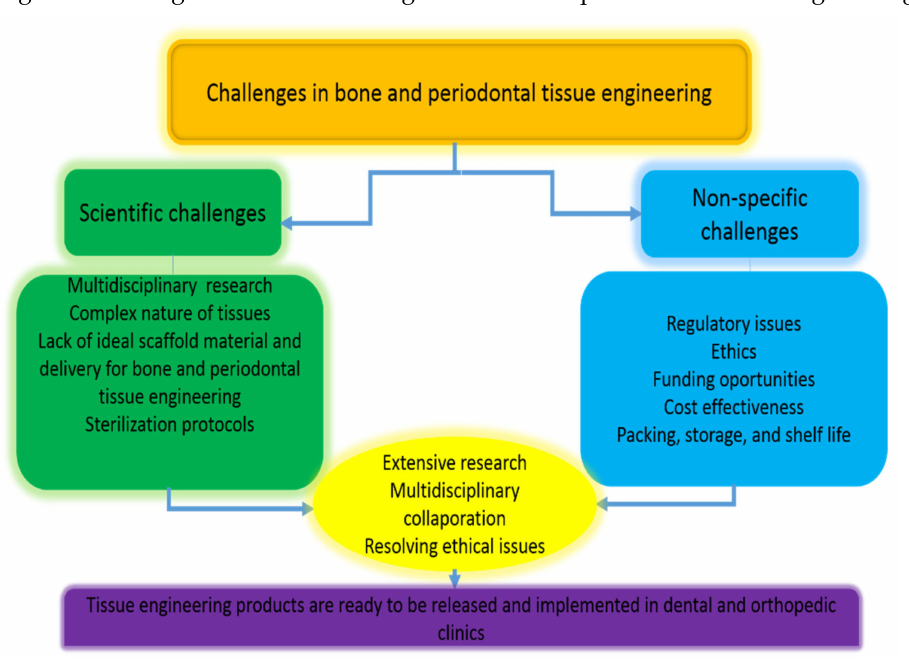
Figure 6. Challenges in bone and periodontal tissue engineering, reproduced and modified from Zafar et al.